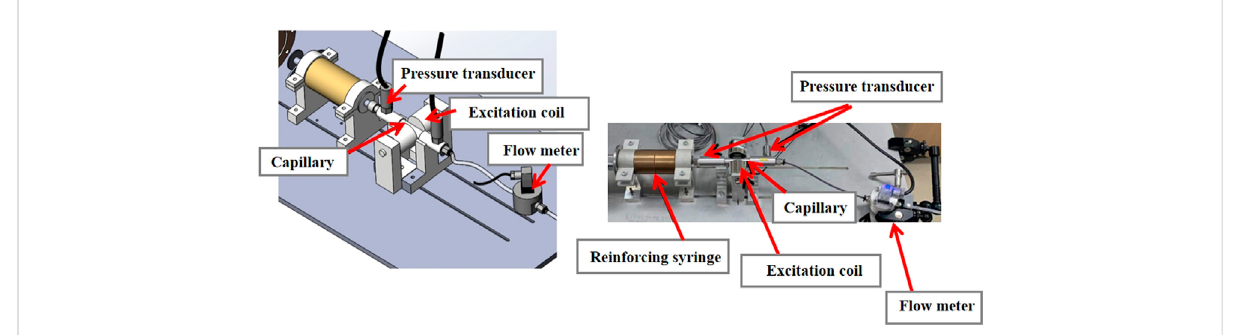
FIGURE 7 Structure diagram of lab-made speed-controlled capillary rheometer.